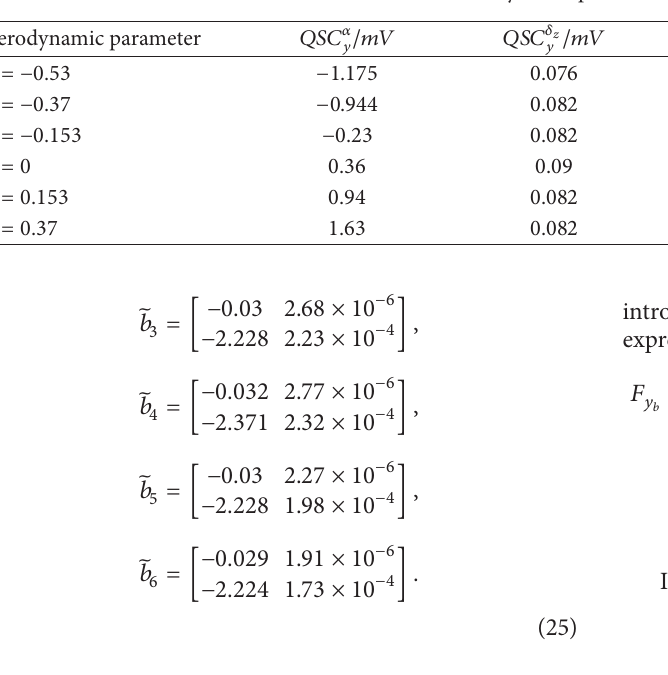
Table 2: Aerodynamic parameters of pitch